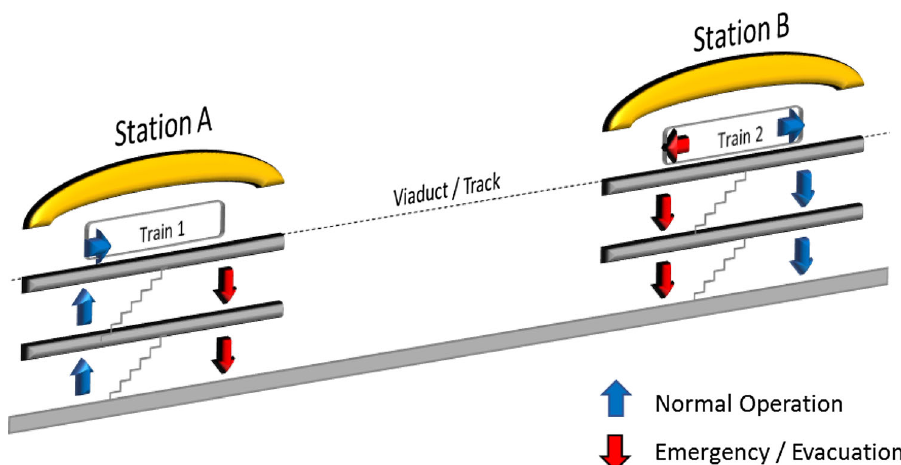
Fig. 2 Framework of study focusing the points of contact between passengers and stations open to the atmosphere, including walking surfaces, stairs, lifts, escalators, and wayfinding required during